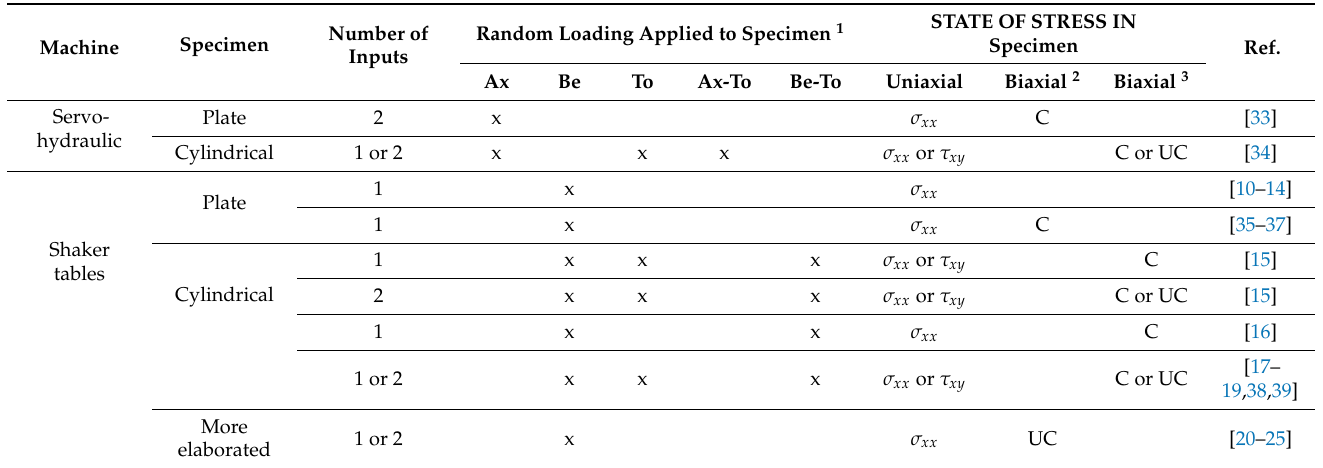
classification criterion of Table 1 may represent a useful guideline to classify any new testing system. Table 1. Classification of fatigue testing systems (C = correlated stress components; UC = uncorrelated stress components). Machine Specimen Servo- hydraulic